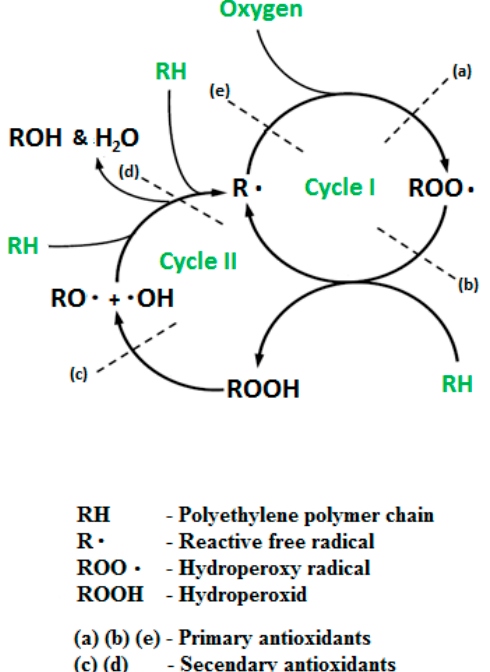
Figure 1. The oxidation cycle in polyethylene (modified from Rowe and Sangam, 2002).